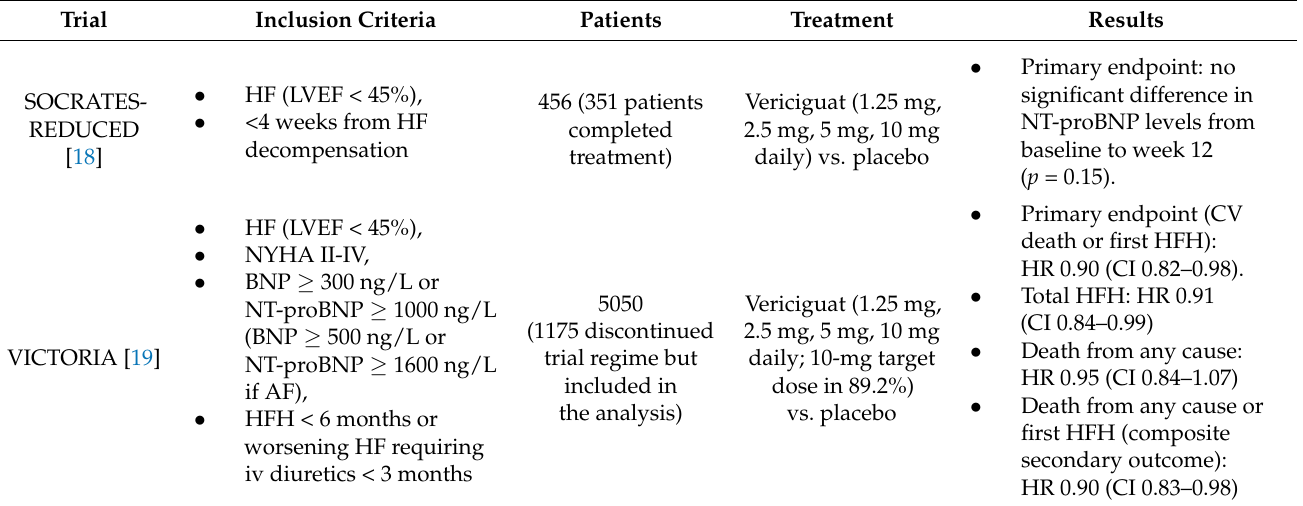
Table 2. Summary of the main results data from the SOCRATES-REDUCED and VICTORIA